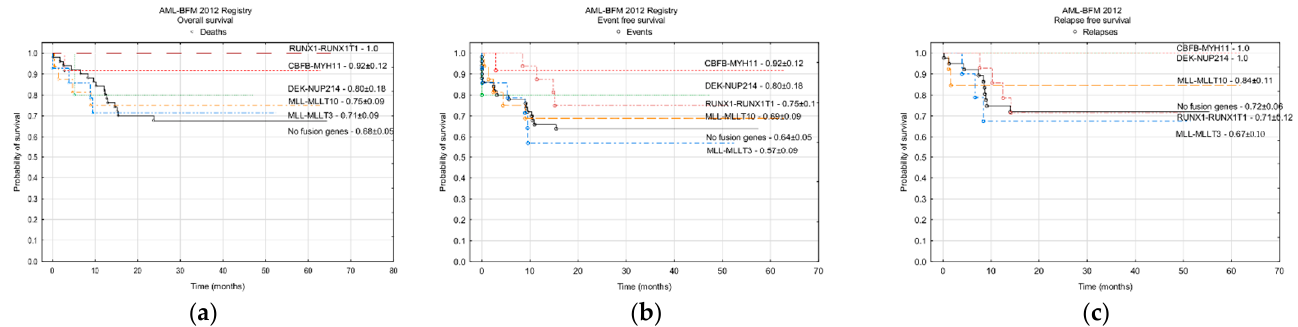
Figure 4. Probability of survival depending on the fusion genes in patients treated with the AML-BFM 2012 Registry. Probabilities of five-year survival are shown: ( a ) overall survival; ( b ) event free survival; ( c ) relapse free survival.